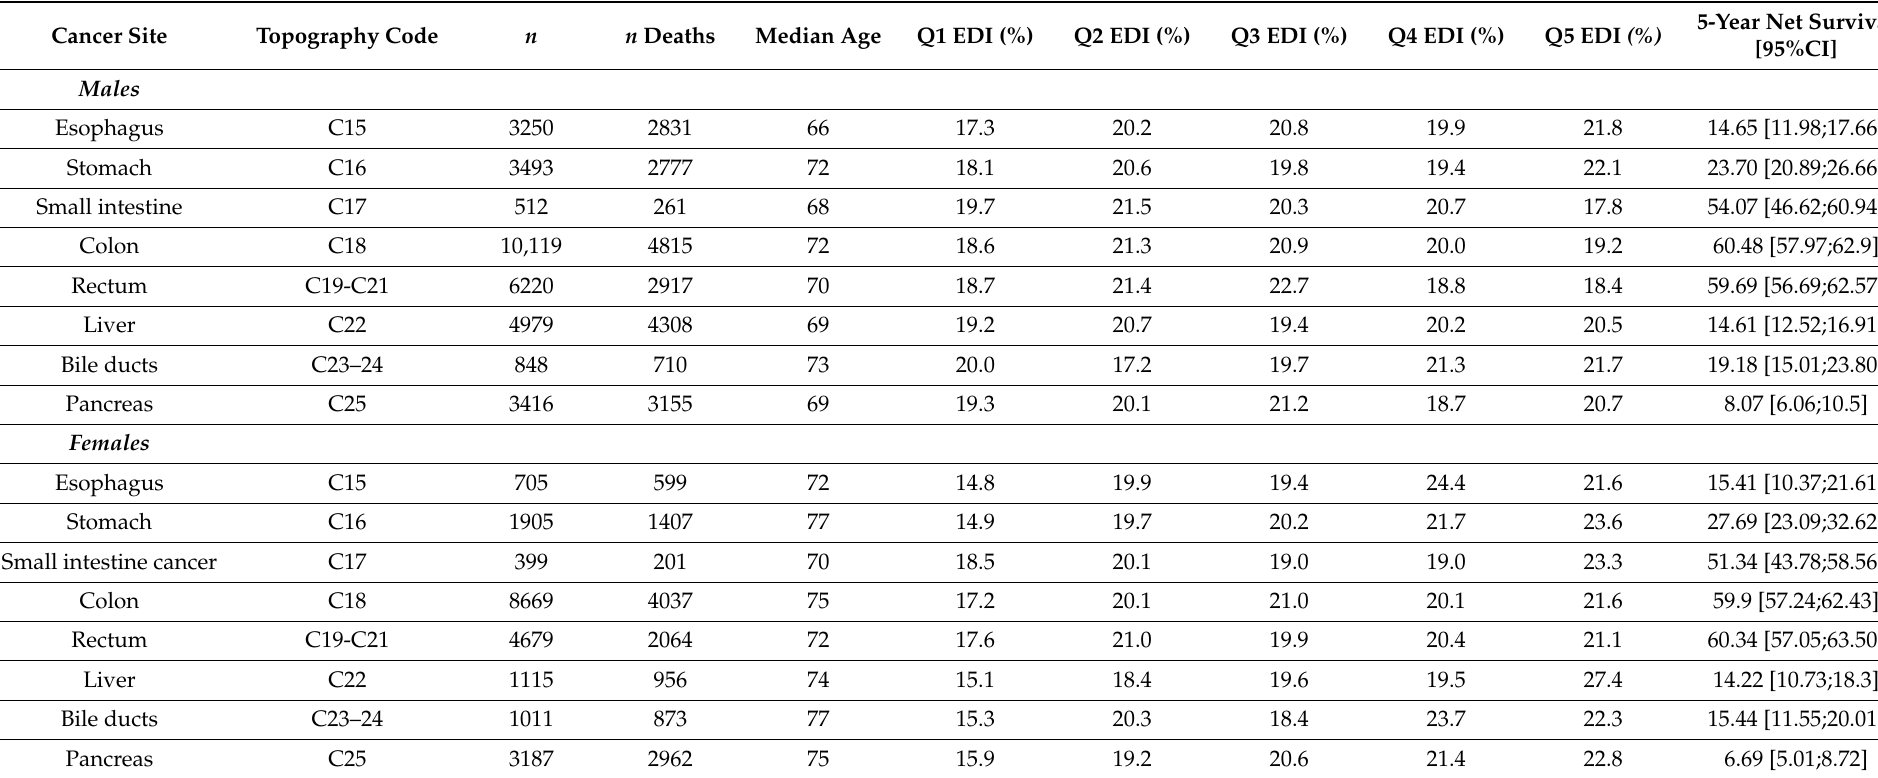
Table 1. Sociodemographic characteristics, EDI national quintile distribution and populational net survival (computed from the selected model, at 5 years of follow-up) according to cancer